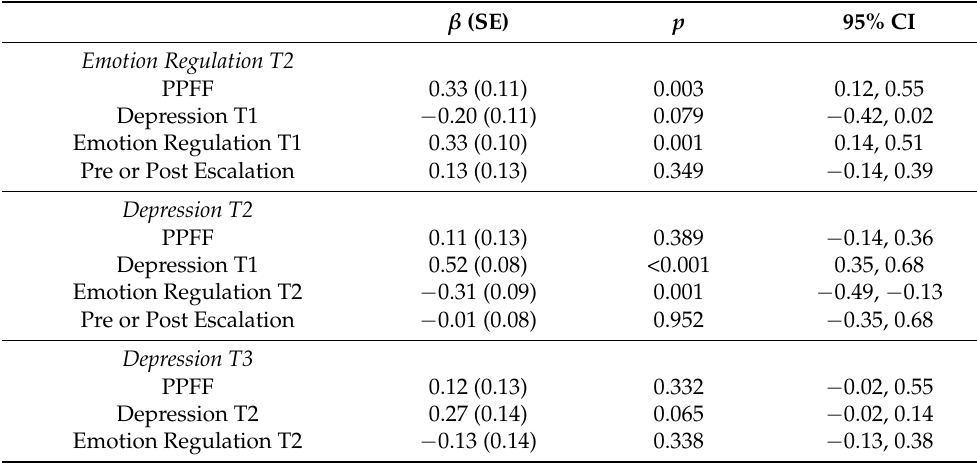
Table 3. Indirect effects model: Mothers’ emotion regulation and depression.